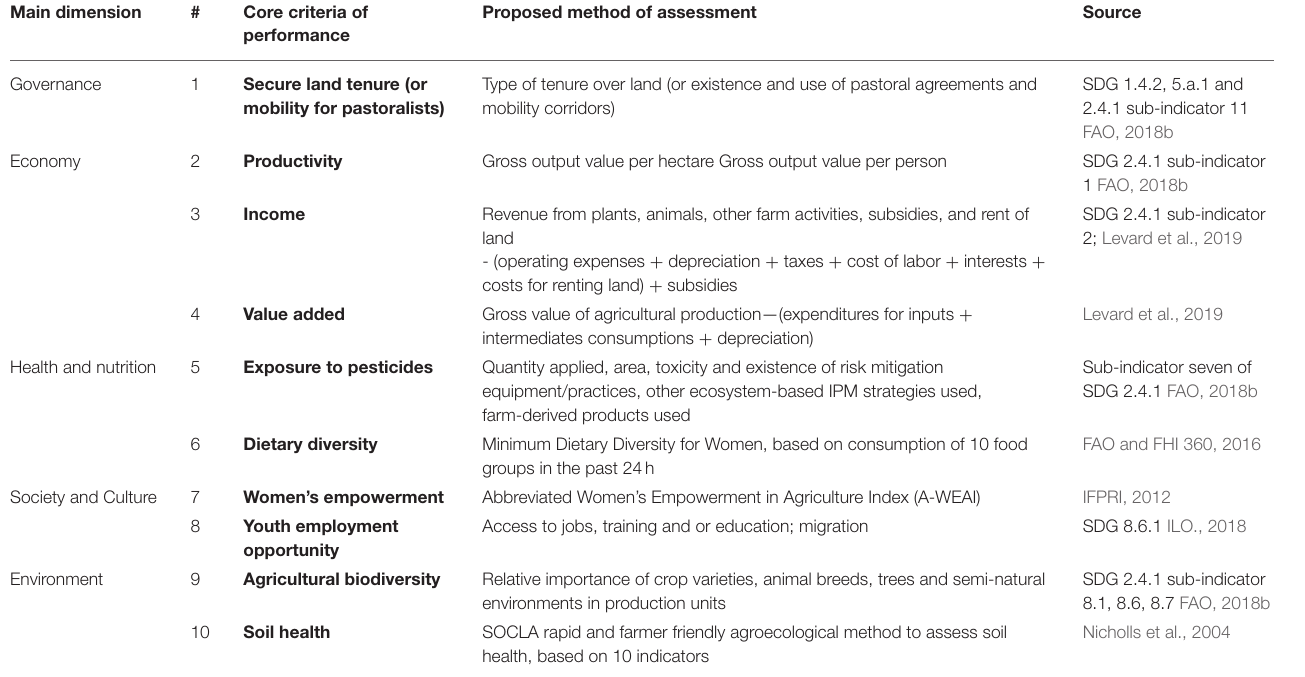
TABLE 4 | Ten Core criteria of performance of agroecology and their links to SDG indicators. Main dimension